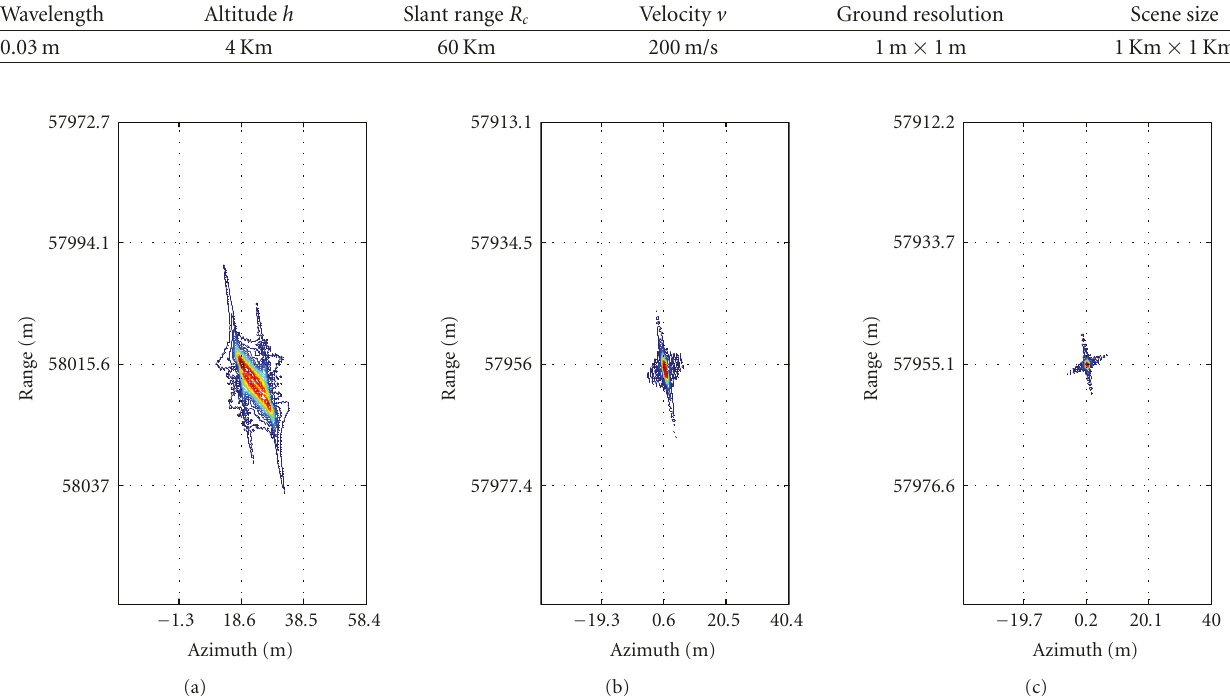
Figure 4: Contour plots of point target by di ff erent algorithms (squint angle ϕ = 15 ◦ ). (a) Processed by the FS algorithm [4]. (b) Processed by the FS algorithm with the dechirping function given in this paper. (c) Processed by the nonlinear FS